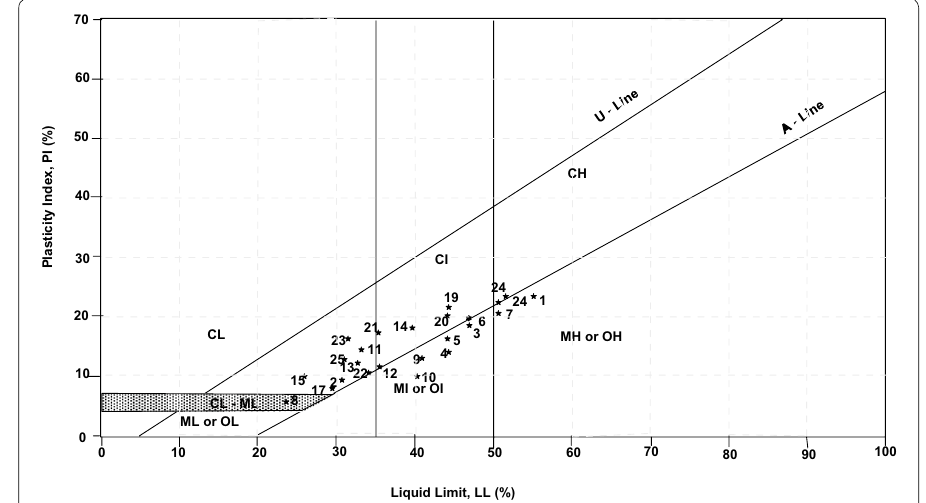
Fig. 6 Plots of the soil samples on casagrande plasticity chart